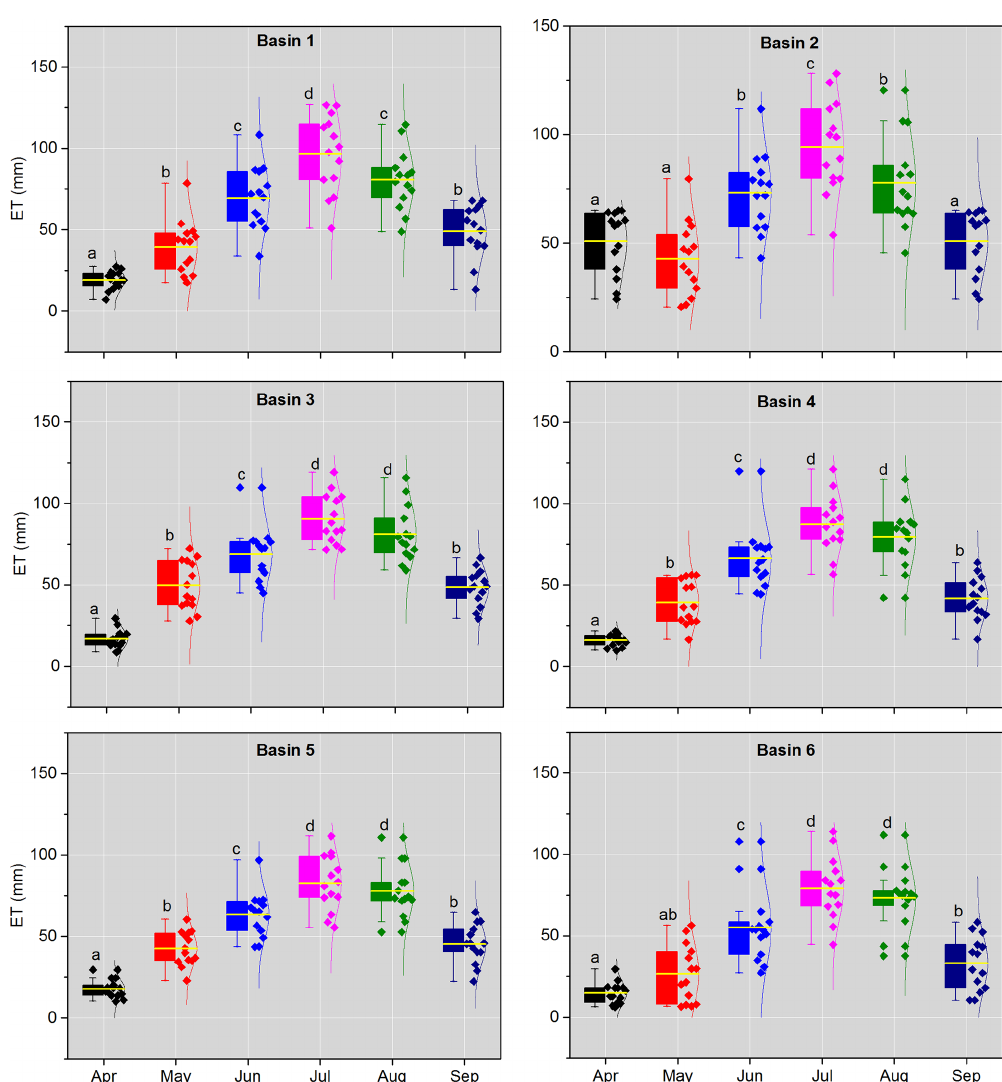
Figure 4. Variations in the monthly ET for each basin during 2001–2014. A distribution curve is shown to the right side of each box plot, and the data points are represented by diamonds. Different letters indicate significant differences at p< 0 .